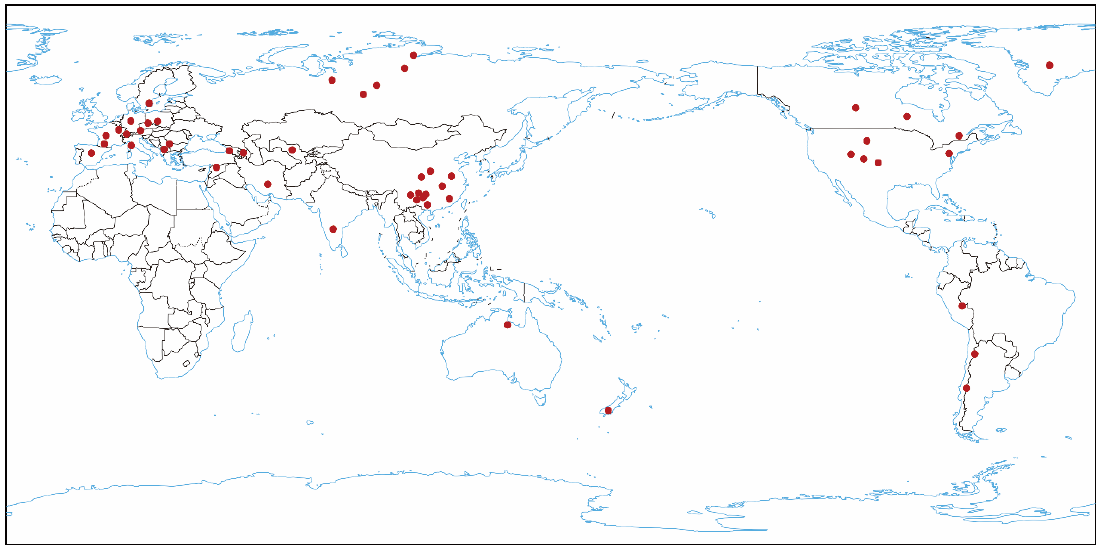
Figure 1. Tl-(bearing) deposits occurrence in the world (modified from